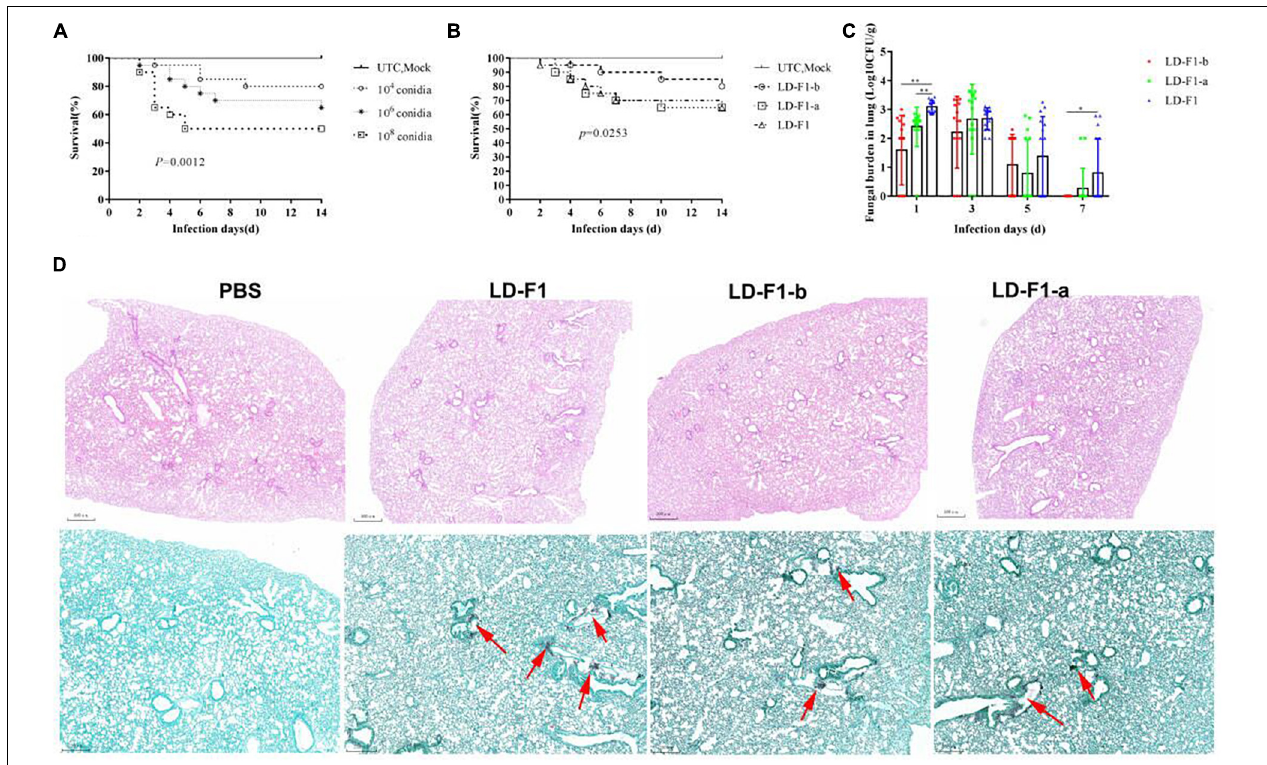
FIGURE 7 | Comparison of virulence in mice of virus-free isolate (LD-F1), AfPV1-infected isolate (LD-F1-b), and AfPV1- and SatRNA-infected isolate (LD-F1-a) by intratracheal injection. (A) Determination of the optimal spore concentration of A. flavus for pathogenicity testing in immunosuppressed mice inoculated with 50 µ L spores of A. flavus isolate LD-F1 ranging in concentration from 10 4 , 10 6 to 10 8 CFU/mL. (B) Survival of mice inoculated with spores of virus-free isolate (LD-F1), AfPV1-infected isolate (LD-F1-b), and AfPV1- and SatRNA-infected isolate (LD-F1-a) over a 14 days incubation period. (C) Fungal burden in lung tissue over 7 days. (D) Histological observation at 3 days post-inoculation in lung tissue infected with the virus-free isolate (LD-F1), AfPV1-infected isolate (LD-F1-b), and AfPV1- and SatRNA-infected isolate (LD-F1-a), and the HE staining is on top, while the GMS stain is below, and the red arrows indicate hyphae growth. Control experiments are comprised of untouched mice (UTC) and saline buffer injected immunosuppressive mice (Mock). P -values were estimated using Log rank, non-parametric Kruskal–Wallis and Dunn’s multiple comparison tests. * P < 0.05, ** P < 0.01, *** P <